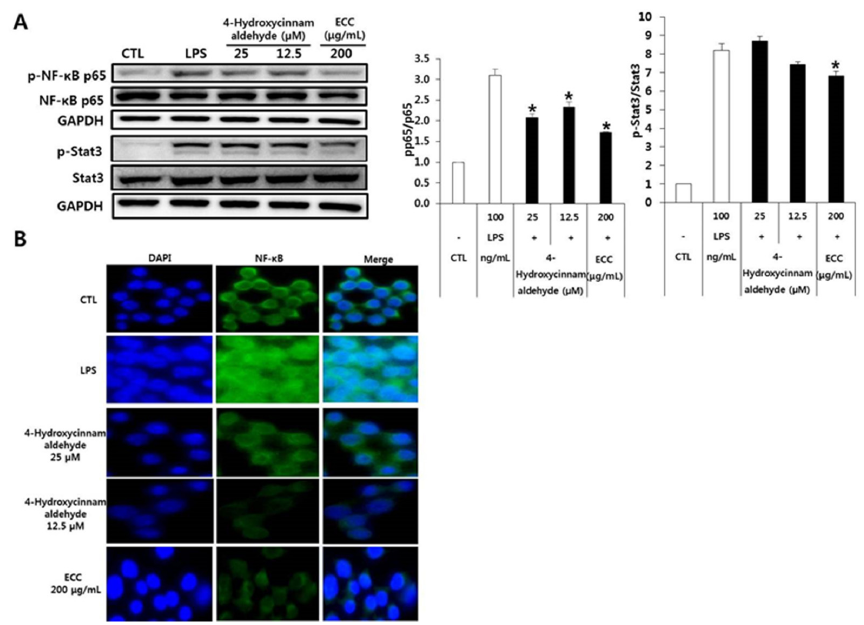
Figure 8. Effect of ECC on the phosphorylation levels of transcription factors in LPS-induced RAW 264.7 cells. ( A ) Effect of ECC on the phosphorylation level of transcription factors using Western blot. Protein extracts were analyzed by Western blot, and quantification of the phosphorylation of NF- κ B and STAT proteins was normalized to GAPDH. GAPDH was used as a loading control. Relative expression of each band was analyzed using Image J software. Values represent the mean ± SD ( n = 3). * p < 0.05 compared to the LPS group. ( B ) Effect of ECC on the translocation of NF- κ B using a microscope. LPS-stimulated RAW 264.7 cells for nuclear translocation were stained with NF- κ B antibody (Alexa Fluor) and counterstained with DAPI. They were observed using a fluorescence microscope (magnification × 60), merged Alexa fluor (NF- κ B), and blue (DAPI) images.